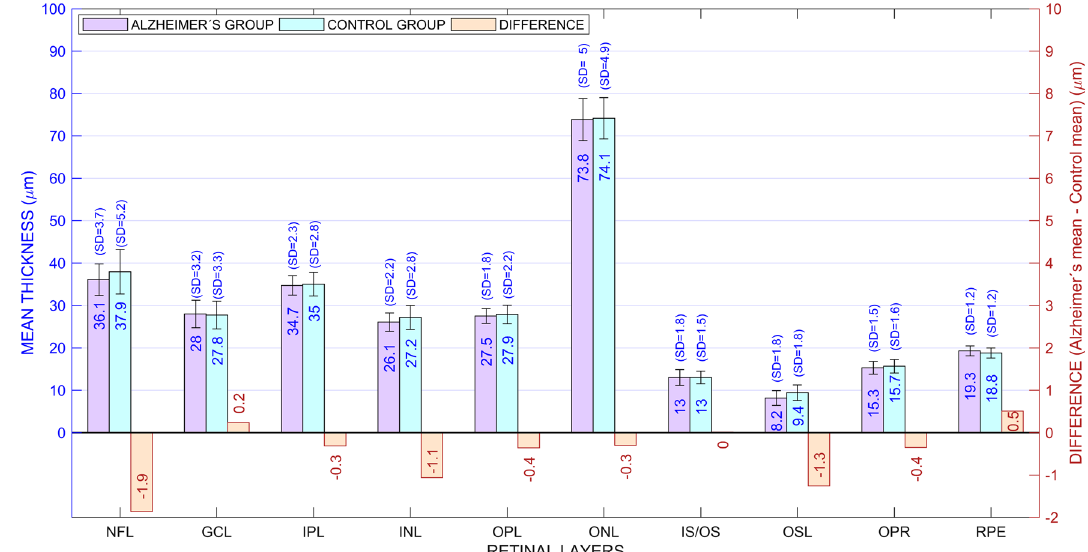
Figure 1. Thickness of retinal layers for patients and controls. The mean thickness is shown within the bars and the standard deviation (SD) is shown above. The difference between the two groups is displayed in orange bars, whose length has been amplified (× 10) to show the trend of retinal layers to be thinner in the AD group. NFL nerve fiber layer, GCL ganglion cell layer, IPL inner plexiform layer, INL inner nuclear layer, OPL outer plexiform layer, ONL outer nuclear layer, IS/OS inner segment/outer segment layer, OSL outer segment layer, OPR outer segment PR/RPE complex, RPE retinal pigment